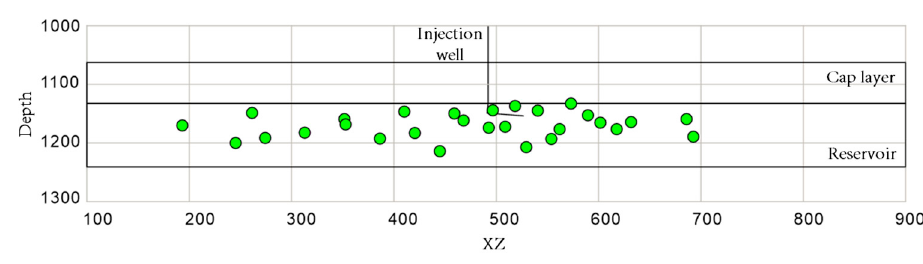
Figure 12. Location of microseismic events (green dots are microseismic events).